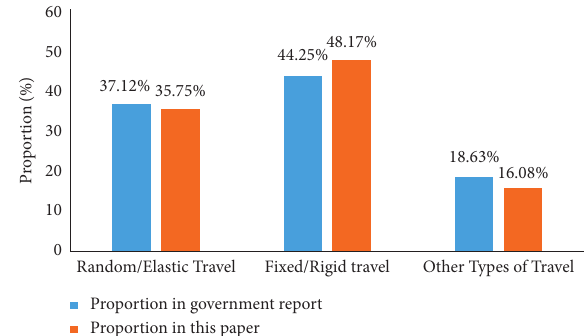
Figure 6: A comparison of ratio distributions of mobility patterns derived from the official report and from this